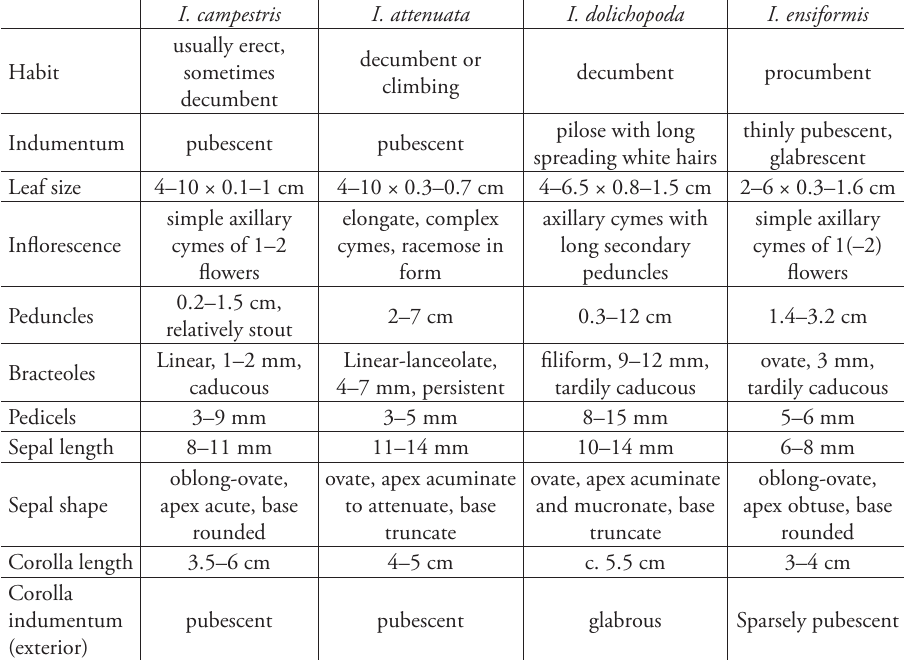
table 1. Differences between Ipomoea campestris , I. attenuata , I. dolichopoda and I. ensiformis. I. campestris I. attenuata I. dolichopoda I.